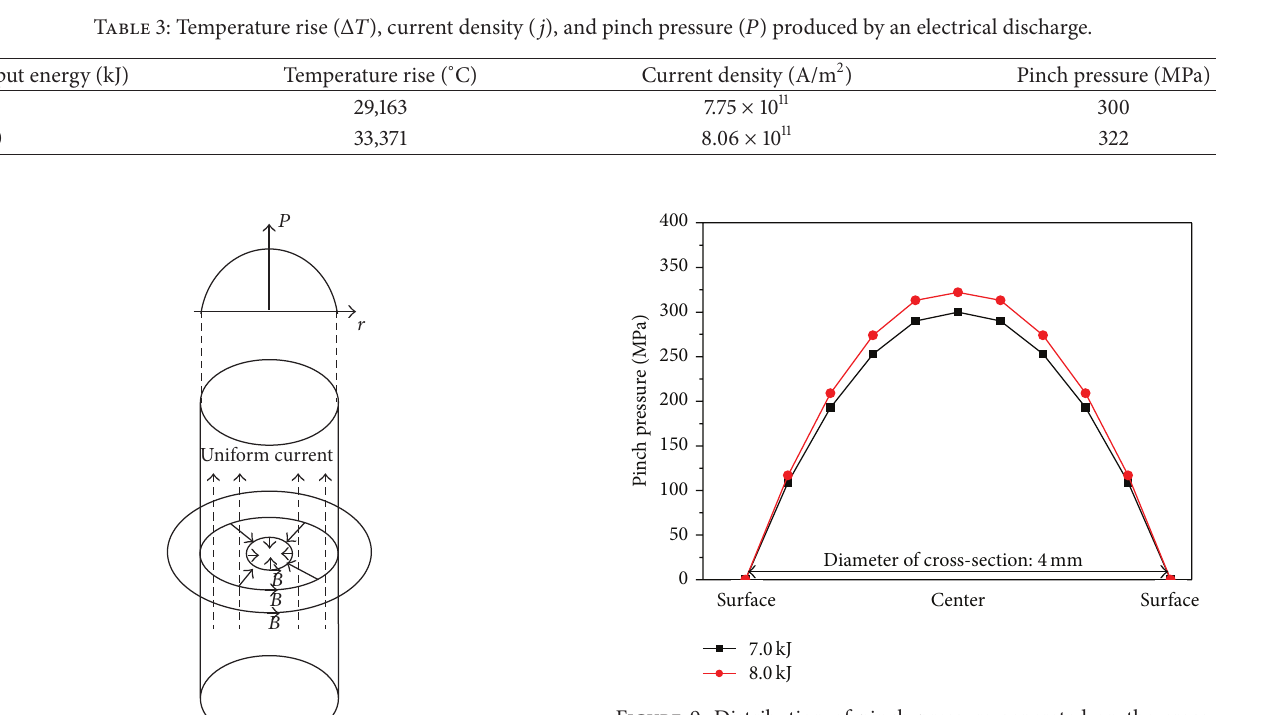
Figure 9: Distribution of pinch pressure generated on the cross- section of EDC Ti 5 Si 3 compact.